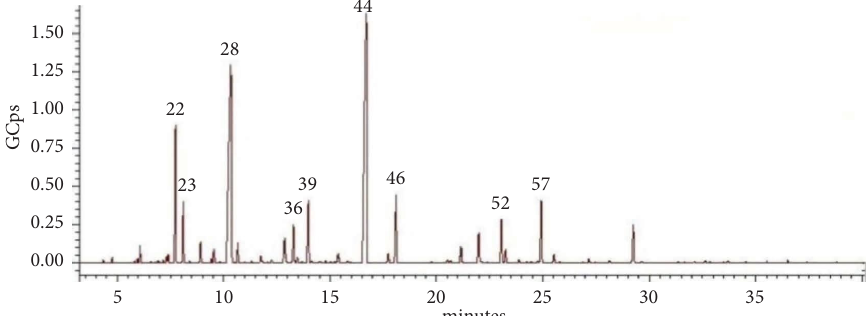
Figure 1: Chromatogram of the cultivated L. angustifolia essential oil. Te numbers are related to 22, trans- β - ocimene; 23, cis- β -ocimene; 28, β -linalool; 36, (-)-terpinen-4-ol; 39, α -terpineol; 44, linalyl acetate; 46, lavandulyl acetate; 52, caryophyllene; 57, cis- β - farnesene.